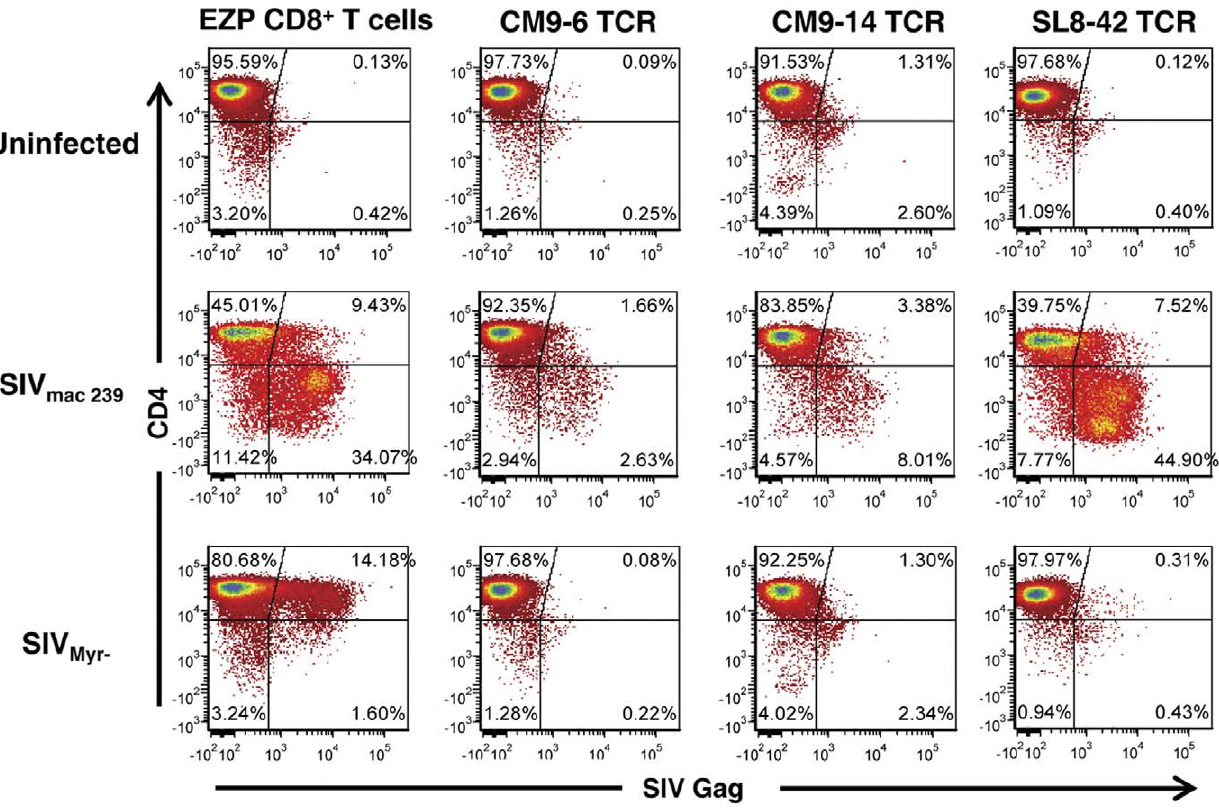
Figure 4. In vitro virus suppression assay of TCR-transduced cell lines. Flow cytometry analyses of mixed cultures consisting of effector CD8 + T-cell lines and a target autologous CD4 + T-cell clone that was untreated or exposed to either wild-type SIV mac239 or SIV myr- are presented. Effectors are labeled above each column and targets are labeled at the left of each row. The effector CD8 + T cells in the co-cultures were stained with CellTrace Violet H and excluded from the analysis so that only the target cells were counted.